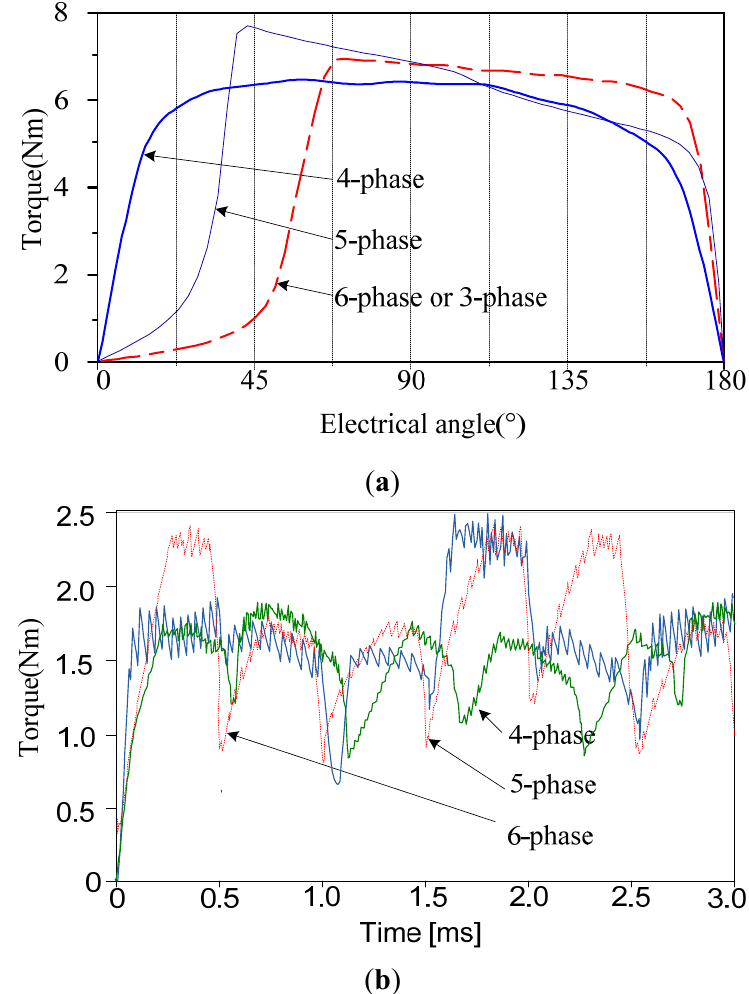
Figure 11. The torque of the multiphase WFDSMs. ( a ) The torque-angle characteristics; ( b ) The torque with one phase isolated in an H bridge